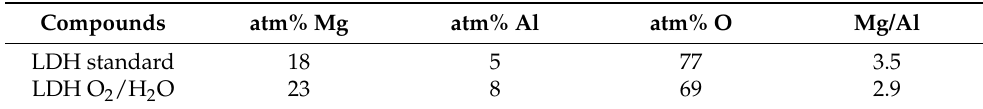
Table 1. Chemical analysis of the as-synthesized LDH sample and of the calcined/rehydrated LDH sample. Figure 4. EDS (energy dispersive spectroscopy) LDH images of ( a ) as-synthesized Al,Mg-LDH and ( b ) calcined samples under O 2 flow and rehydrated with H 2 O vapor.